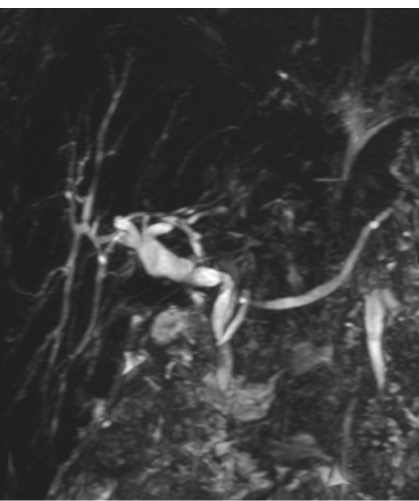
Figure 3: Magnetic resonance cholangiopancreatography (MRCP) showing an acuteangle in the mid-common bile duct with upstream dilatation.